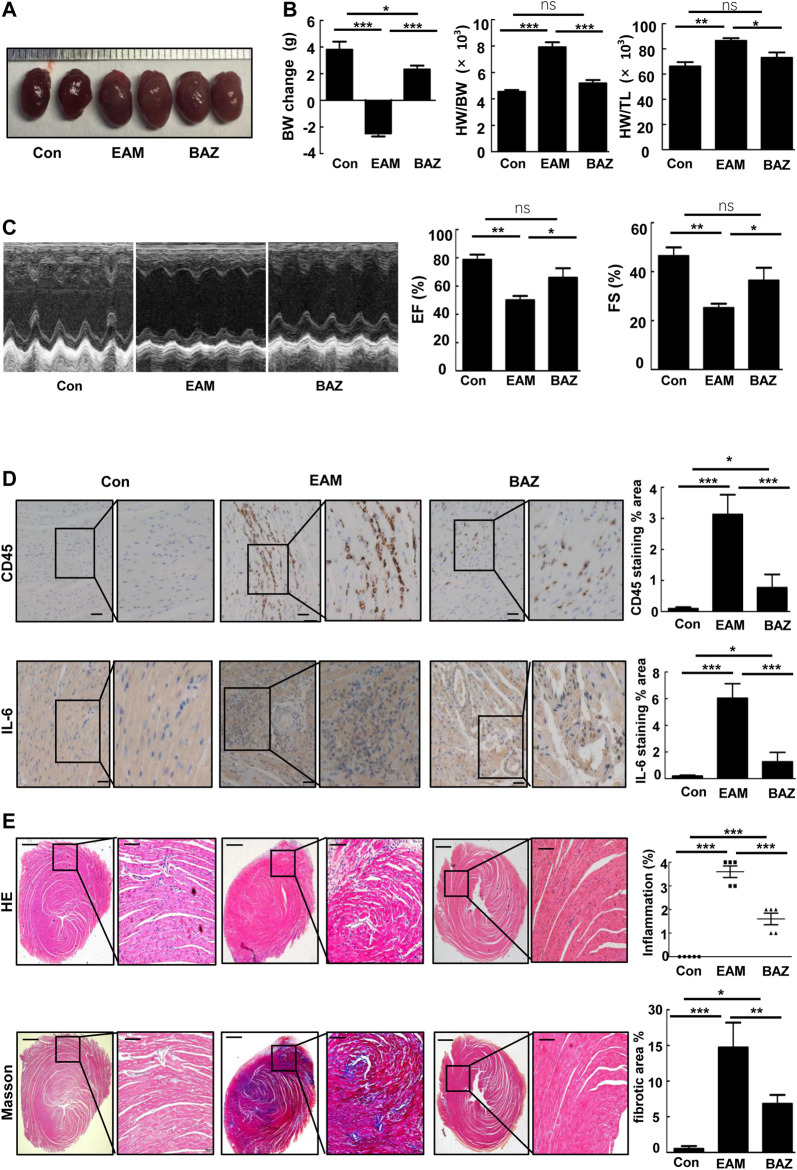
Bazedoxifene ameliorated cardiac inflammation and injury induced by EAM and improved EAM-induced left ventricular dysfunction (A). Representative heart images of the indicated groups (B). Change in body weight, HW/BW ratio, and HW/TL ratio of the indicated groups (C). Representative echocardiography M-mode images and analysis of left ventricular function. Representative images of immunohistochemistry of inflammatory cells stained with anti-CD45 and anti-IL-6 (D) in each heart section. Scale bars: 50 μm. E and F. Representative H and E-stained and Masson staining images of left ventricular sections of indicated groups. Bar graphs on the right show quantitation of data (E) (n = 5). Scale bars: left 0.5 mm, inset 100 μm. Scale bars: left 0.5 mm, inset 100 μm *p < 0.05, **p < 0.01, ***p < 0.001.